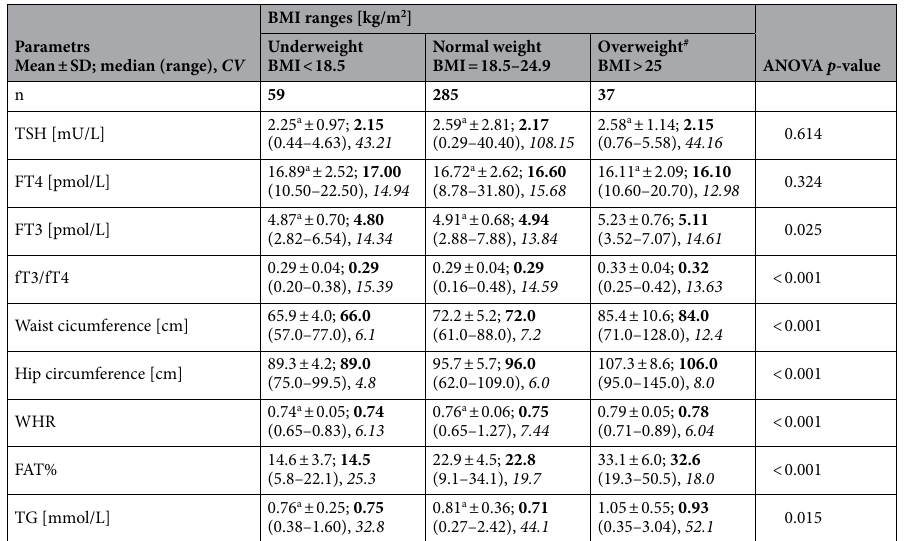
Table 4. Characteristics of the study population. Group means with the same letter indices do not differ significantly from each other, p < 0.050, Tukey HSD post-hoc for equal variances and Games-Howell test for unequal variances. Median values are in bold, CV in italic style. # Overweight refers to both and overweight subjects + obesity class I + obesity class II (n = 28 + n = 8 + n = 1) CV = coefficient of variation.